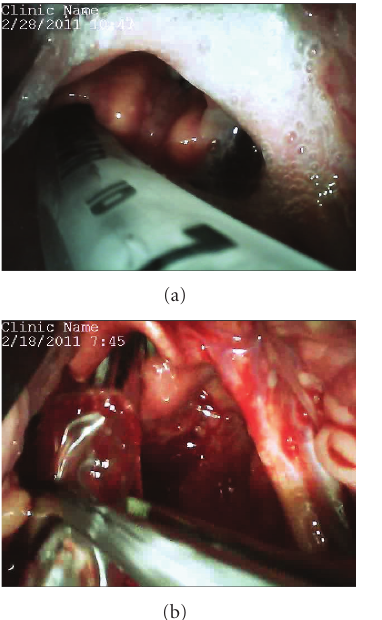
Figure 5: Examples of operator errors observed using the GlideScope Direct. (a) Esophageal intubation. (b) Grasping of the nasoendotracheal tube cu ff with the Magill